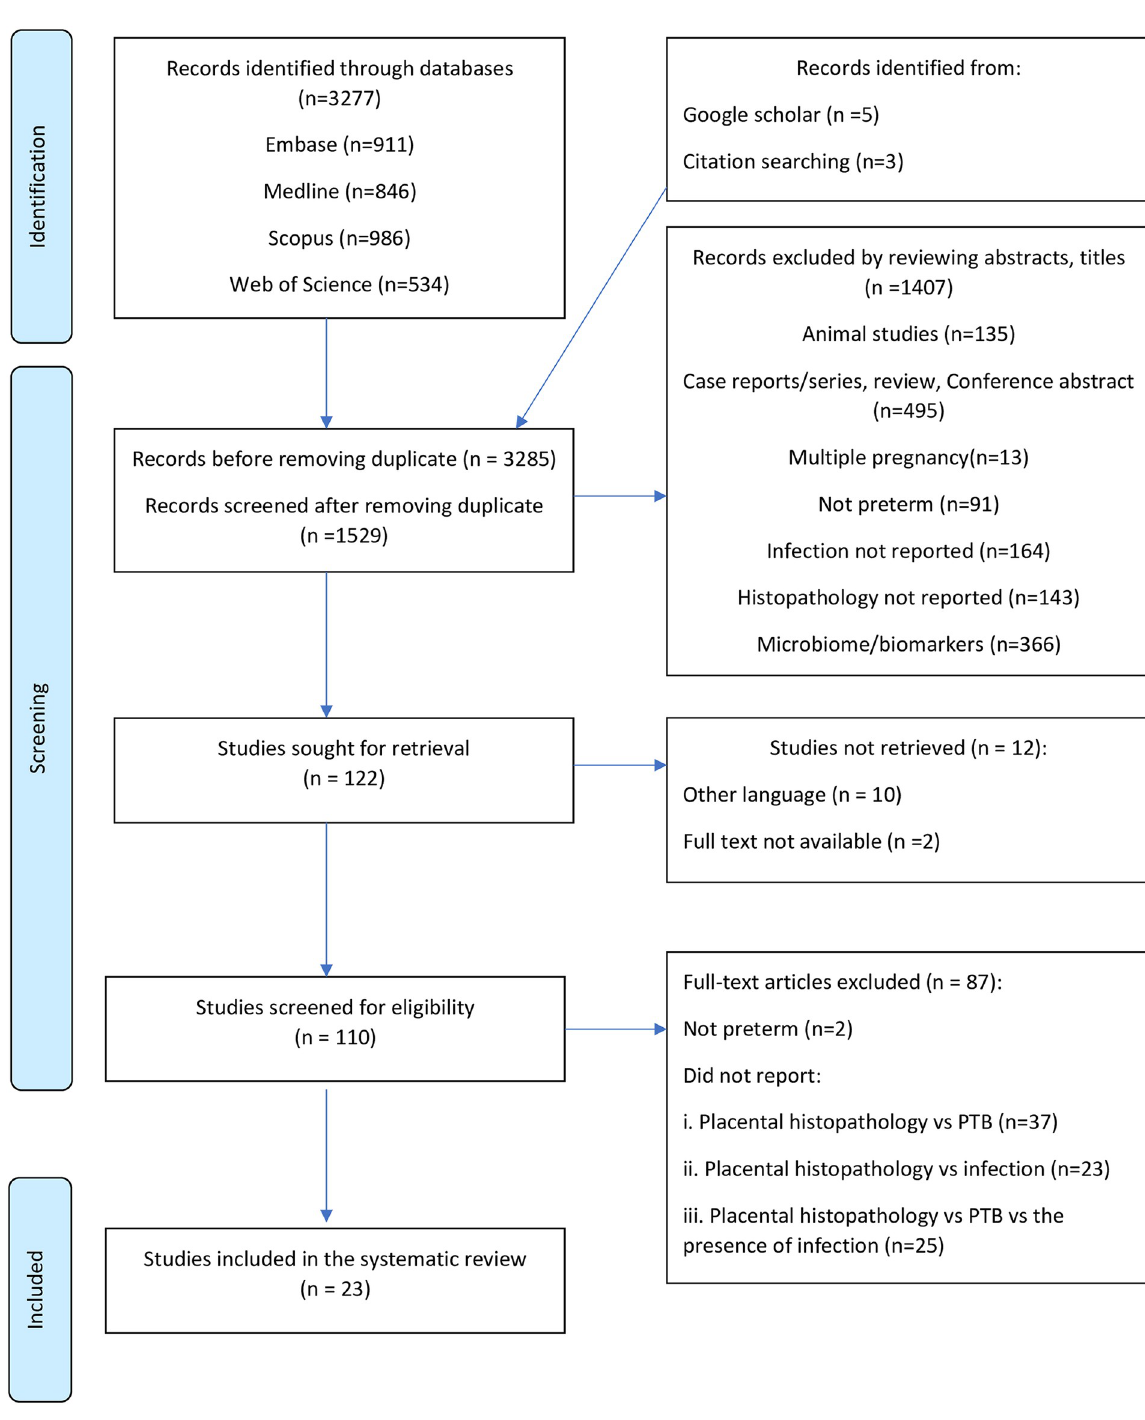
While an estimated gestational age of less than 37 weeks was the most common PTB defini- tion, various lower cut-offs were used: seven different gestational age windows were described